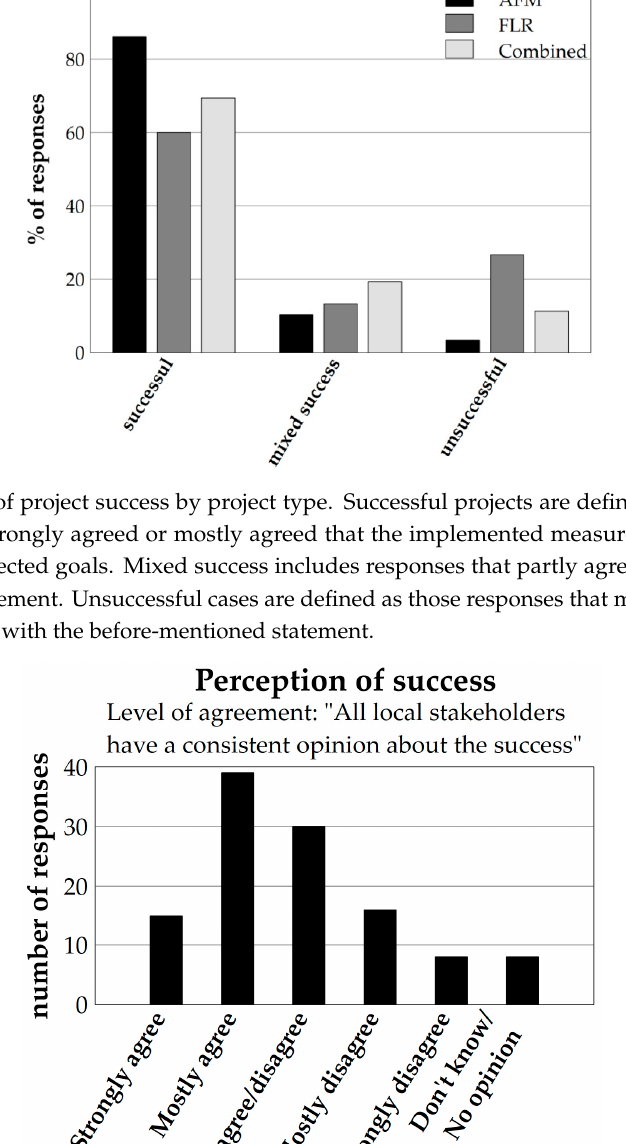
Figure 3. Management targets by different priorities reported in the survey for FLR and combined approaches. NTFP abbreviates Non ‐ timber forest products.